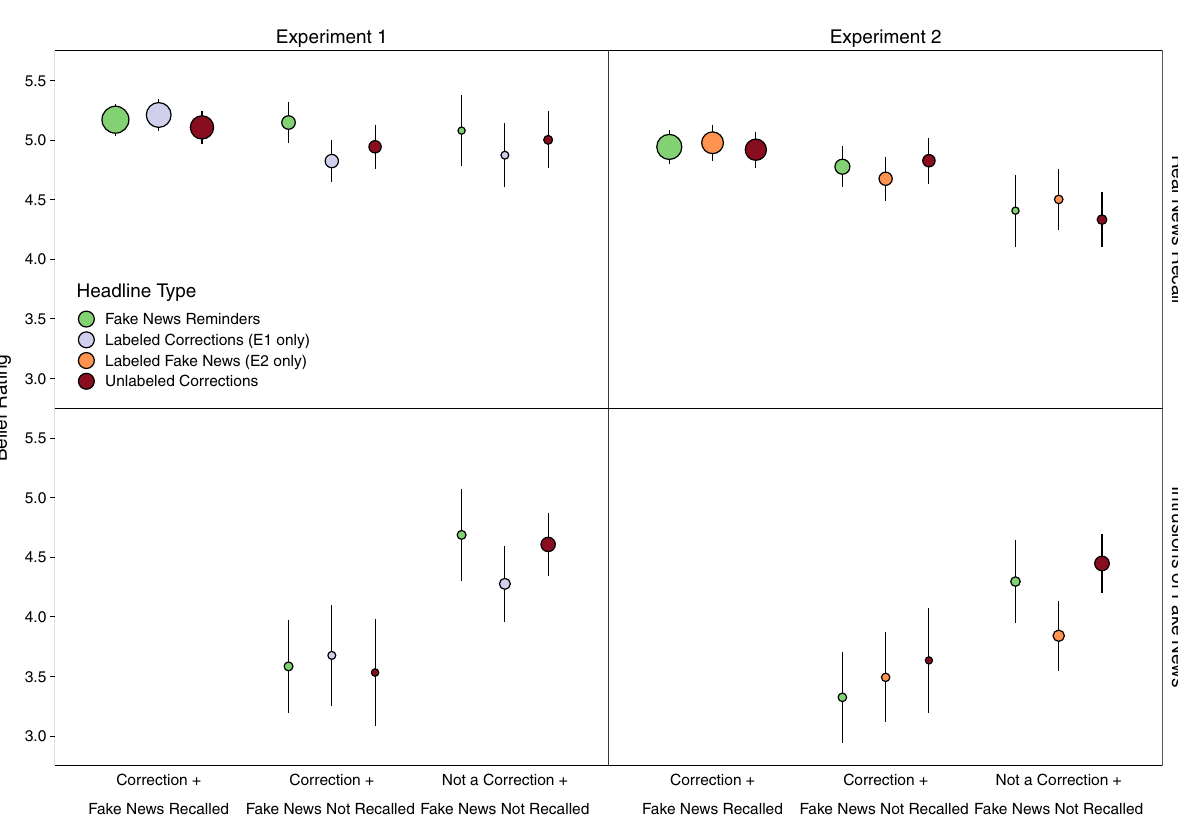
Figure 6. Belief ratings for real news recall and intrusions of fake news conditioned on correction classifications for each correction headline type condition. Points are ratings estimated with mixed effects models, and error bars are 95% confidence intervals. Point sizes indicate for each cell the proportion of observations, which are also displayed in Supplementary Table S5. Values are not displayed for intrusions for classified corrections when fake news was recalled due to sparse